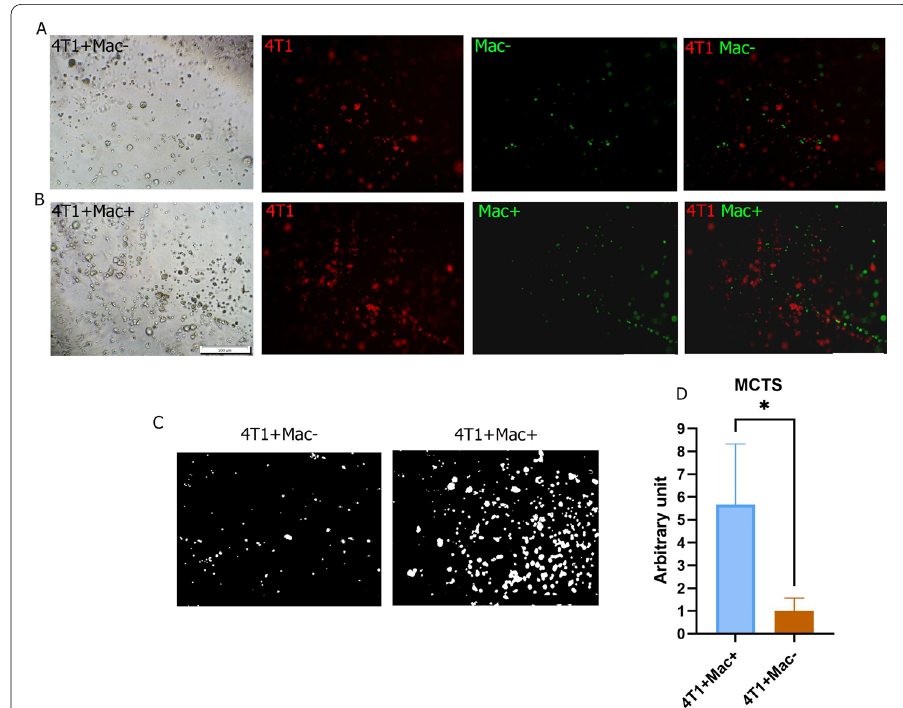
Fig. 5 Multicellular tumor spheroids (MCTS) by 4T1 cells after 72 h coculture with MSC CXCL12 − / − ‑primed ( A ) and MSC CXCL12 + / + ‑primed macrophages ( B ). 4T1 tumor cells and macrophages were labeled with CM‑DiI and CFSE, then cocultured in the Vitrogel matrix. Representative mask images of MCTS by 4T1 cells in each group produced by the MATLAB software ( C ). The number of 4T1 colonies and the size of tumor spheroids were greater after coculturing 4T1 cells with macrophages primed with MSCs CXCL12+/+ ( D ). * P < 0.5, Student’s t‑test. Mac,